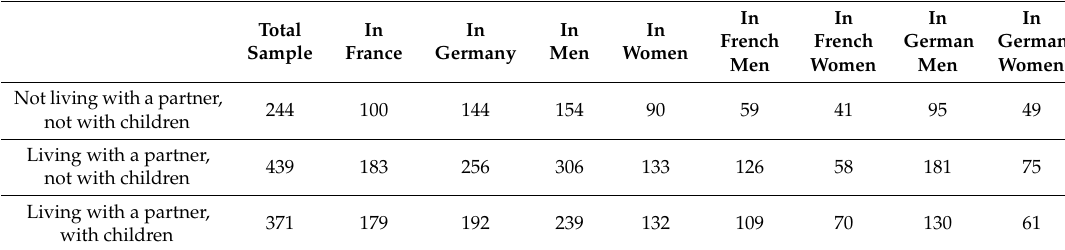
Table 1. Frequency of categorization living with a partner / living with children in overall sample and depending on gender and